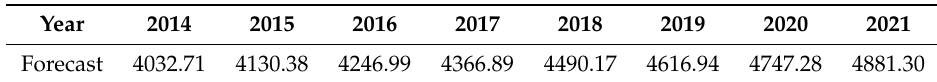
Table 8. Forecast data F 1 of I 12 .